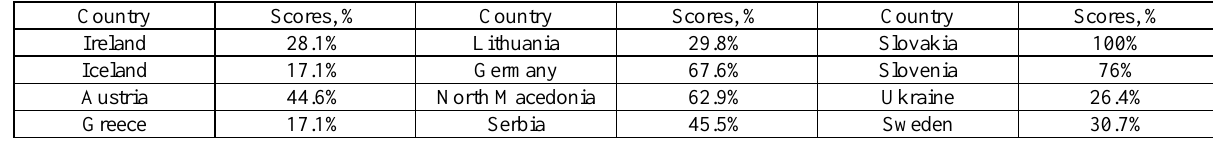
Table 4. Countries’ distribution by the level of new registered enterprises (for the 2nd group of the 2nd